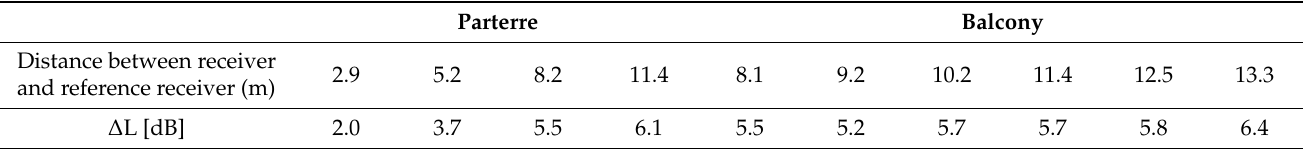
Figure 10. Map of the equivalent sound pressure levels in dB, for the variable acoustic configuration which provides maximum sound absorption (suitable for oratory/speech use) (configuration A). Table 5. Differences between sound pressure levels registered close to the source and that obtained at a receivers’ line, for oratory/speech use ( ∆ L). Parterre Balcony Distance between receiver and reference receiver